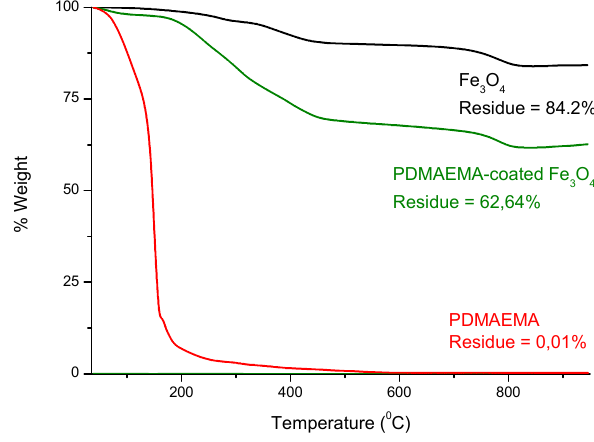
Figure 5. Thermograms of the magnetic nanoparticles.